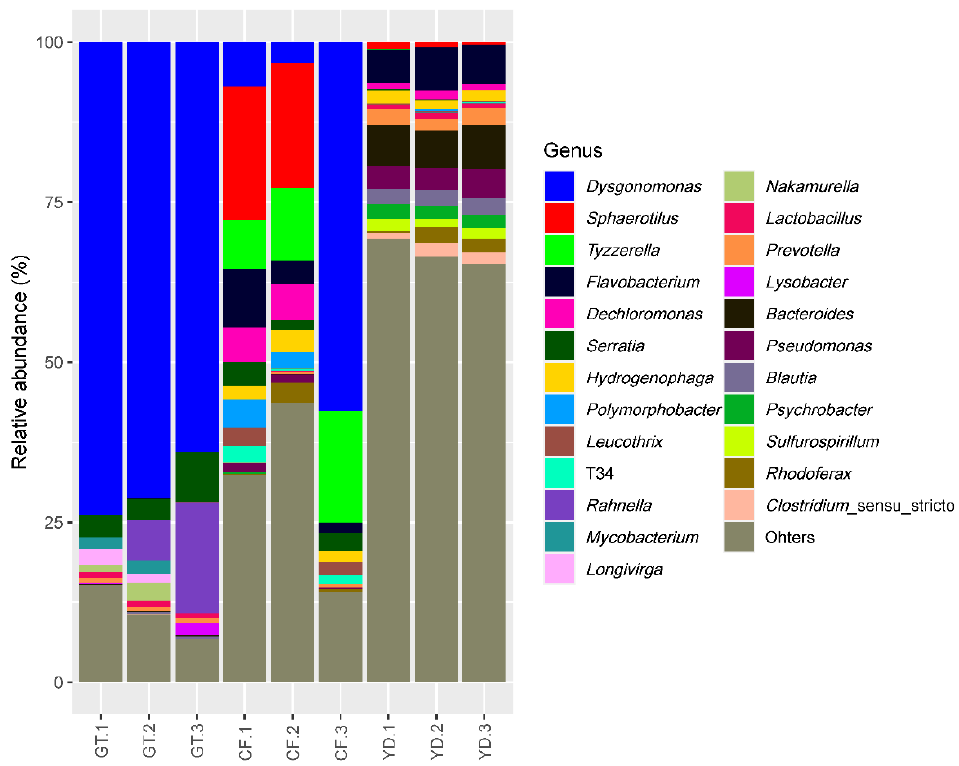
Figure 6. Relative abundance of the 10 most abundant genera in the studied samples. GT: G. tokunagai ; CF: C. flaviplumus ; YD: Yeon Deung stream water.